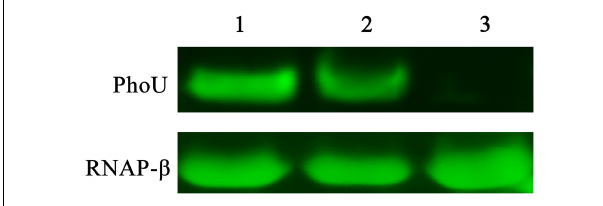
FIGURE 1 | Western blot verified differences in PhoU expression levels between wild-type and recombinant strains. 1, 2, and 3 represent samples of Saccharopolyspora pogona - phoU , S. pogona and S. pogona - (cid:49) phoU , respectively. A 20 µ g whole protein sample of each strain was used separately for comparative analysis. RNAP- β was used as an internal reference protein.